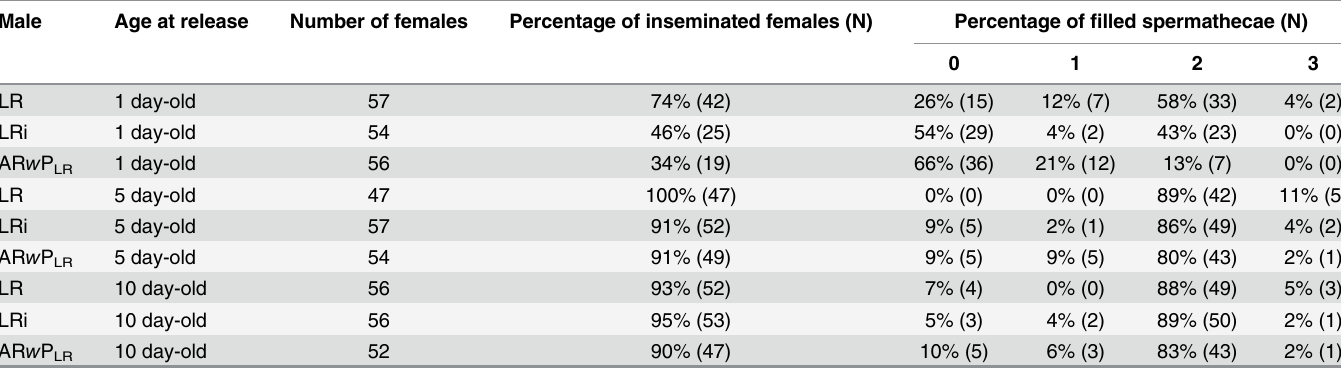
Table 1. Insemination capacity of irradiated and incompatible males caged with females for 24 h.